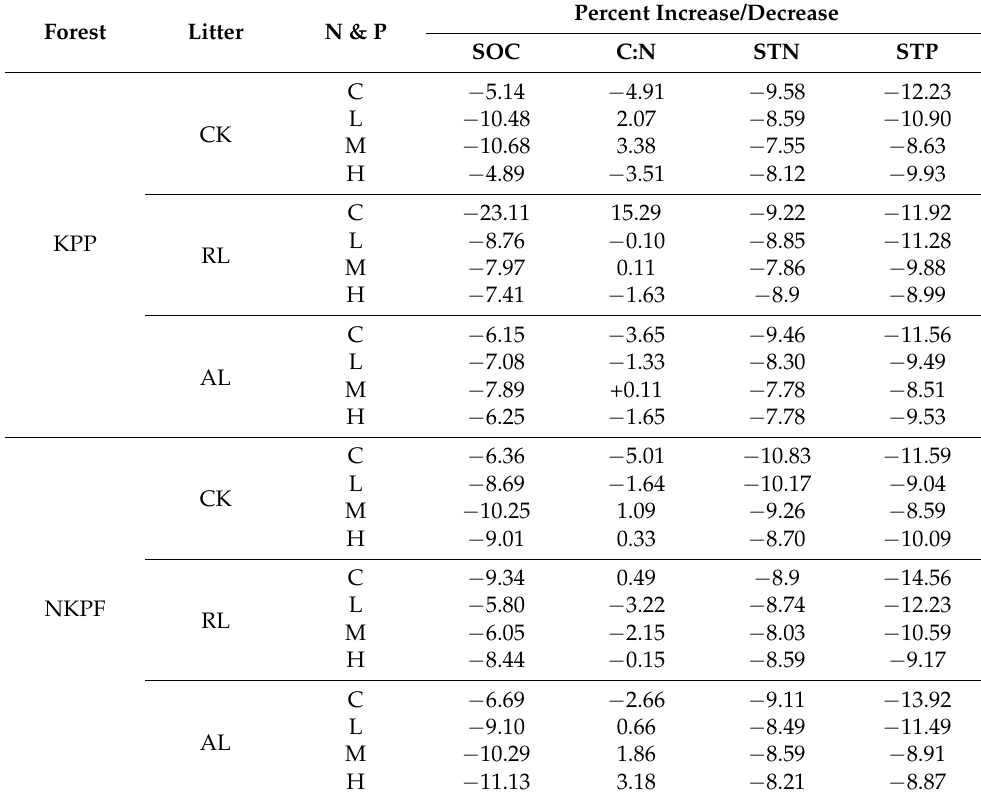
Table 4. Increase/decrease in SOC, C:N, STN and STP at the end of experiment as compared to initial stages.